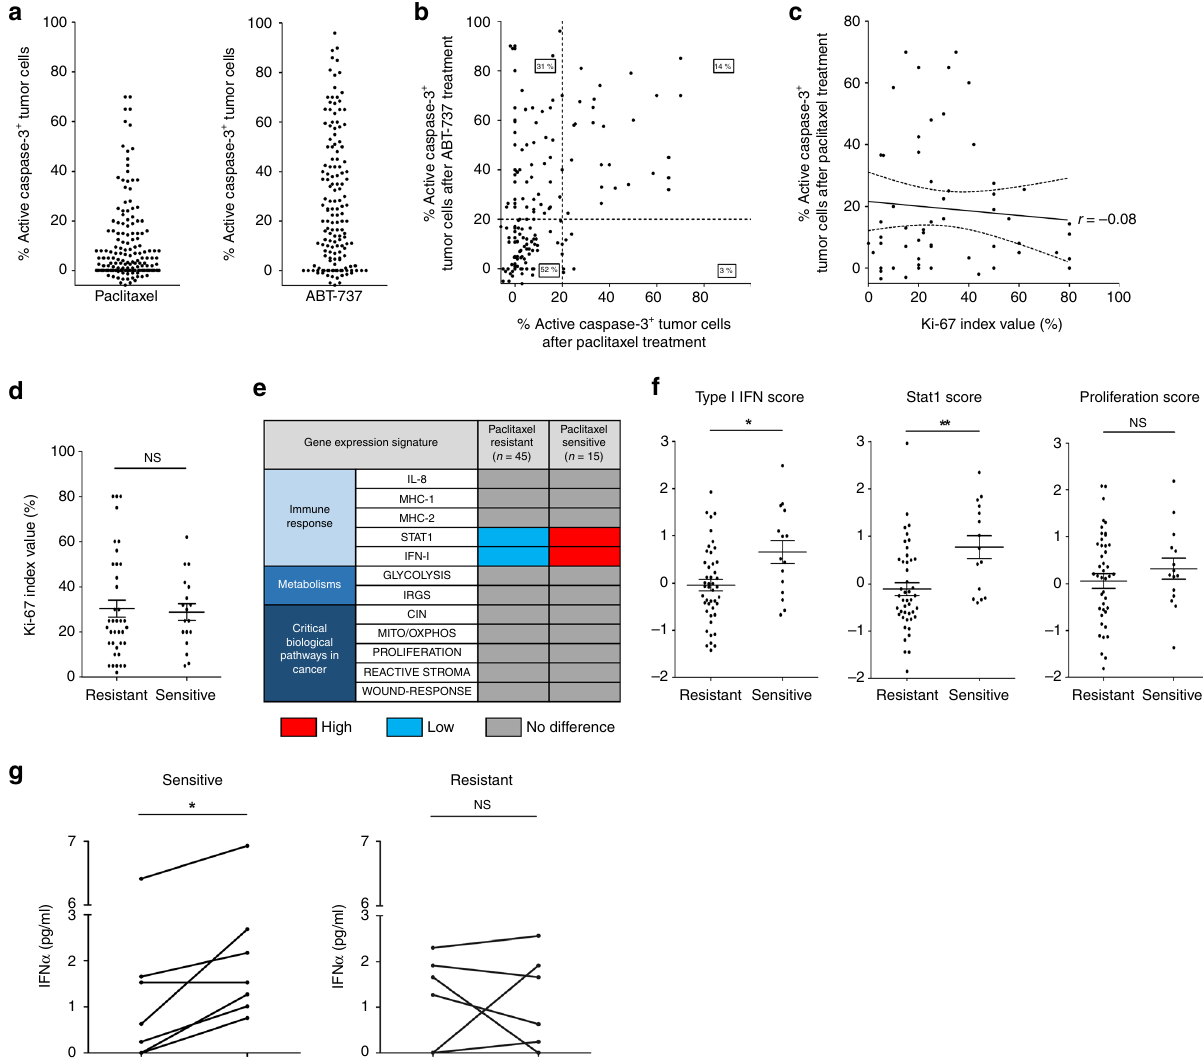
Fig. 2 Type I IFN signature and high apoptotic primed state coincide with breast tumor ex vivo sensitivity to paclitaxel. a , b Apoptotic index in 163 fresh human breast tumors de fi ned by the % of active caspase-3 positive tumor cells detected by IHC after 48 h ex vivo paclitaxel (left) or ABT-737 (right) treatments separately ( a ) and co-response ( b ). c , d Tumor Ki-67 index (%) in 56 ABT-737 sensitive tumors (above 20% of active caspase-3 positive tumor cells) related to the % of active caspase-3 positive tumor after paclitaxel treatment c or related to paclitaxel sensitivity/resistance (20% apoptotic index threshold) ( d ). e Comparison of gene expression signatures between both paclitaxel resistant and paclitaxel sensitive tumor groups (60 classi fi ed tumors based on their ex vivo paclitaxel sensitivity). f STAT1, type I IFN and proliferation scores obtained from the transcriptome. g IFN α quanti fi cation in supernatants of tumor slices treated or not with paclitaxel. n = 5 sensitive tumors and n = 6 resistant tumors. Error bars indicate mean + / − SEM; Two- sided unpaired ( d , f ) and paired ( g ) t -test. The symbols correspond to a p -value inferior to *0.05 and **0.01. NS: not signi fi